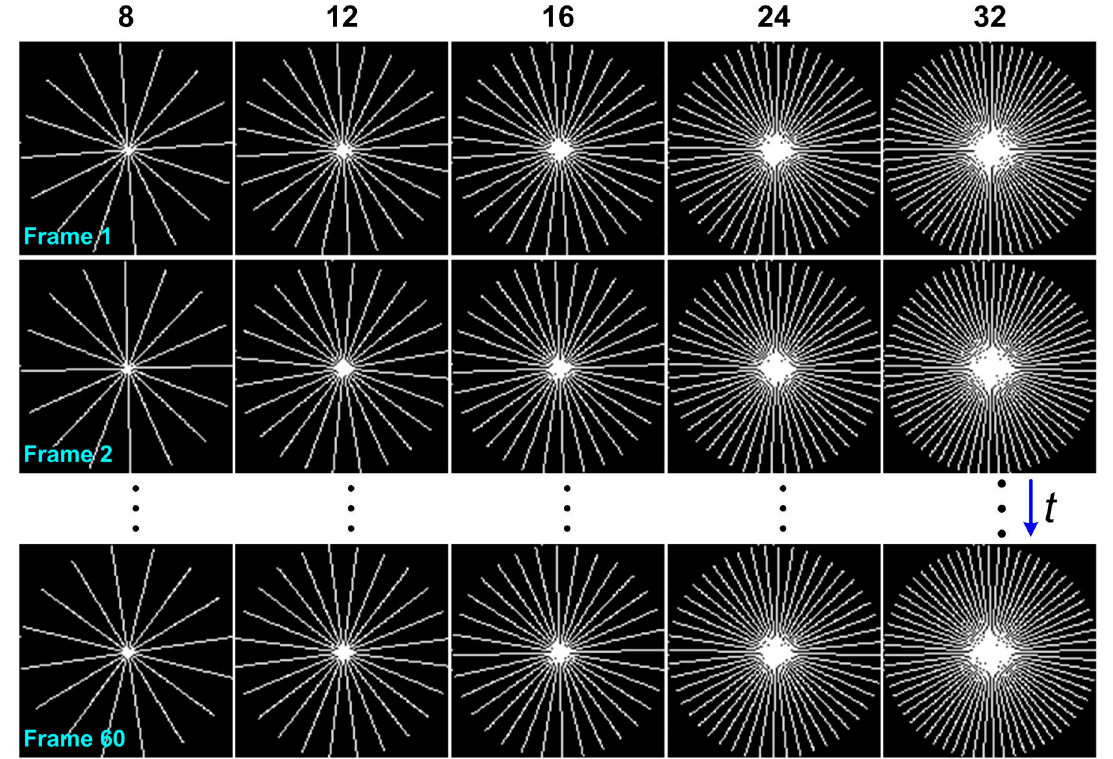
Figure 2. Radial sampling trajectories with N number of uniformly spaced rays in each frame with subsequent random rotations across time frames. From left to right: different number of radial rays ranging from N = 8, 12, 16, 24 and 32 was considered to simulate the undersampled ( k , t ) -space